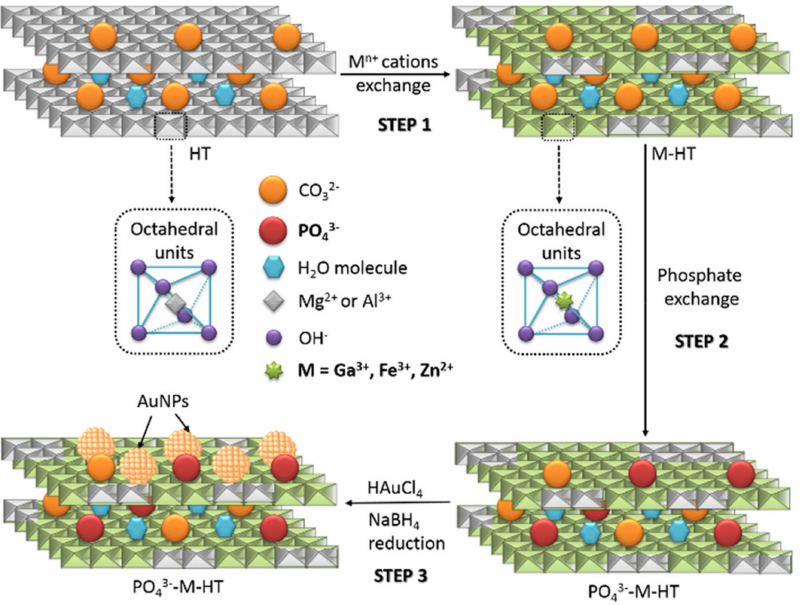
Figure 6. Schematic representation of the synthesis of Au/PO 43 − -M-HT catalysts (Reprinted from [107] with permission of Elsevier,